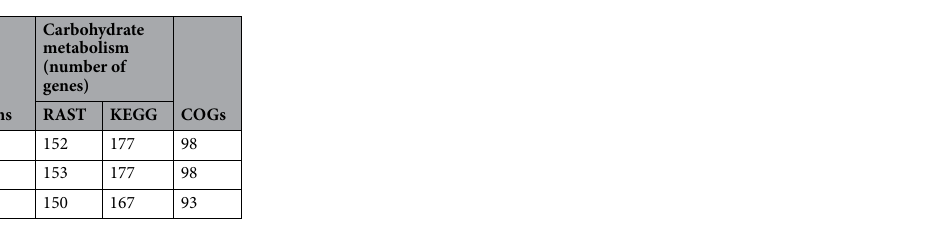
Table 4. Number of genes responsible for carbohydrate metabolism according to RAST and KEGG